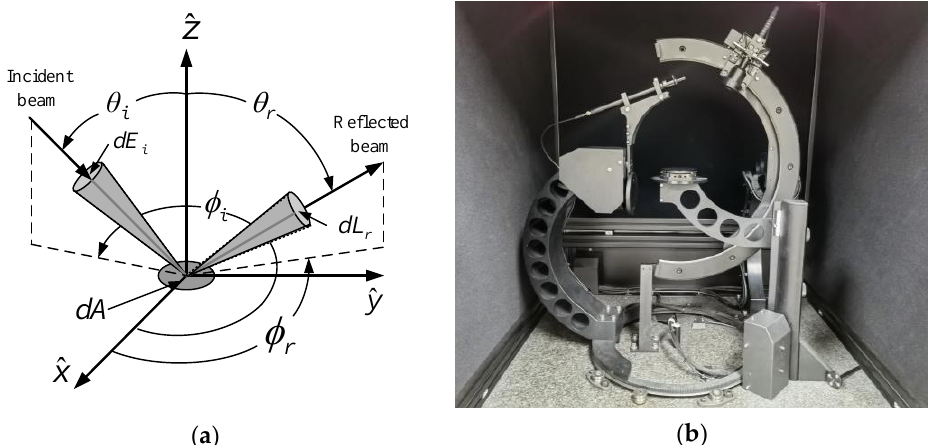
Figure 2. Schematic diagram of the BRDF geometry and the measuring instrument used in this paper. ( a ) Schematic diagram of the BRDF geometry; ( b ) the REFLET-180 BRDF measuring instrument. Yellow thermal control material and silicon solar cells are two primary surface ma- terials of space targets. In this paper, their BRDF data are measured by the REFLET-180 BRDF measuring instrument as shown in Figure 2b. The specific material samples and some corresponding measurement results are shown in Figure 3.